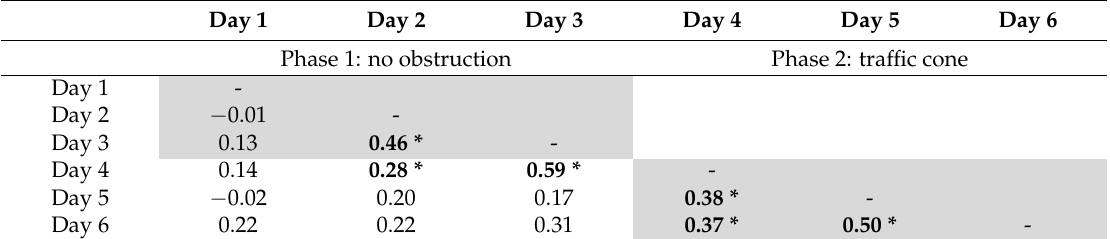
Table 2. Spearman’s rank correlation coefficients for Order of movement through the funnel on days 1–6 of acclimation testing. Significant correlations are denoted with bold font and the symbol ‘*’ ( p < 0.05). Day 1 Phase 2: traffic